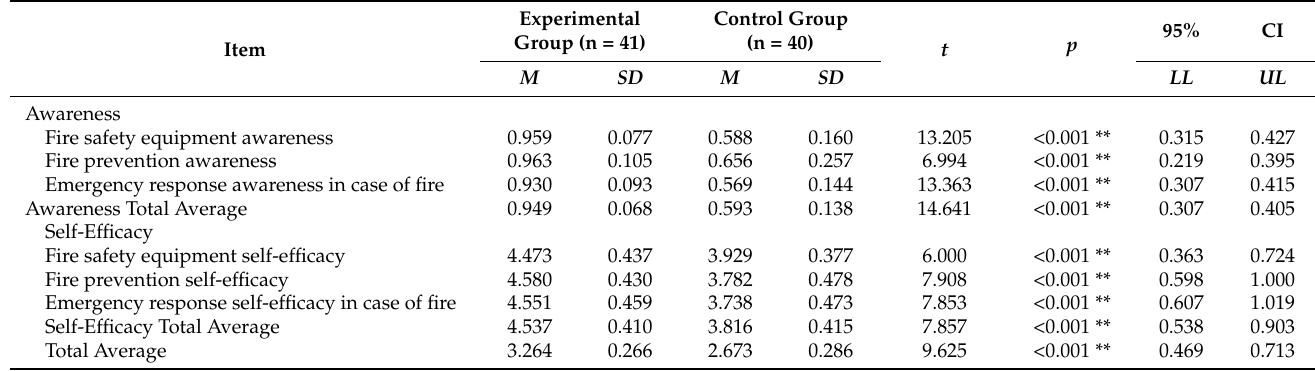
Table 3. Comparison of research subjects’ awareness of and self-efficacy in fire prevention and emergency response after fire safety training intervention (N =